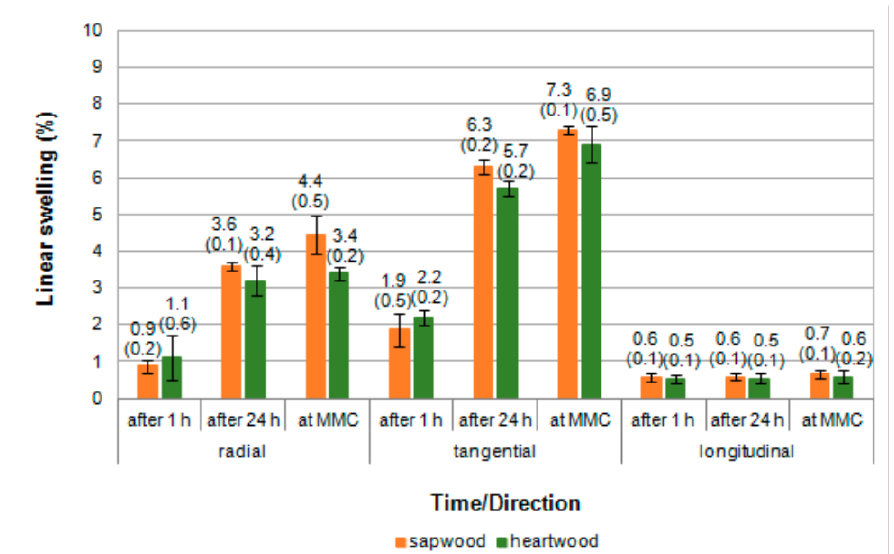
Figure 9. Swelling in the radial, tangential, and longitudinal directions of the sapwood and heart- wood of oriental arborvitae after 1 h and 24 h, and at maximum moisture content (MMC); ± (SD).